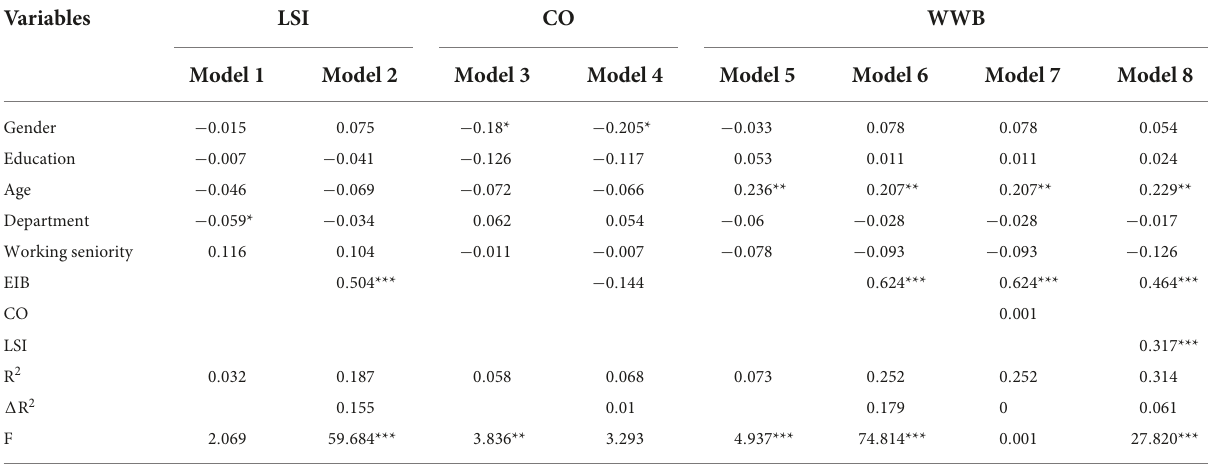
TABLE 5 Hierarchical regression analysis